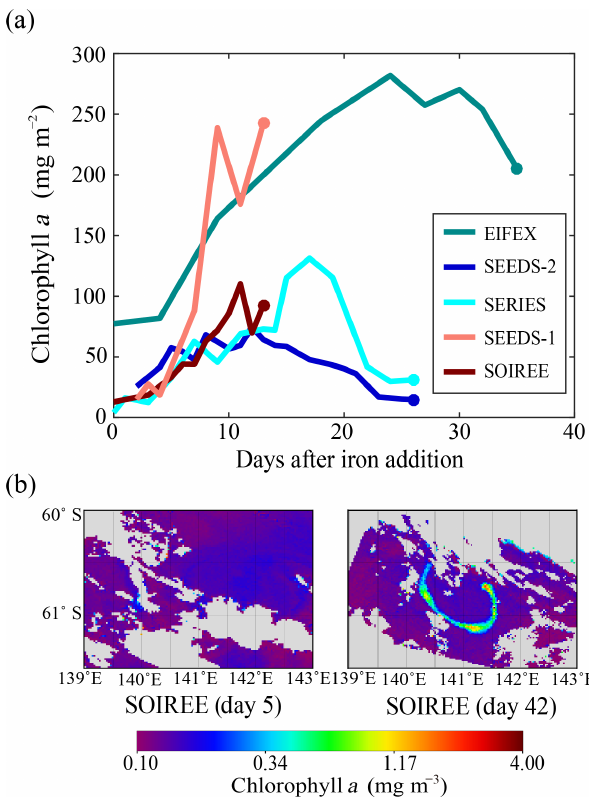
Figure 10. (a) Time series of mixed-layer-depth-integrated chloro- phyll a concentrations (mgm − 2 ) during the Southern Ocean Iron Release Experiment (SOIREE) (brown line), Subarctic Pacific iron Experiment for Ecosystem Dynamics Study 1 (SEEDS-1) (coral line), Subarctic Ecosystem Response to Iron Enrichment Study (SE- RIES) (cyan line), SEEDS-2 (blue line), and European Iron Fer- tilization Experiment (EIFEX) (teal line). (b) The distributions of chlorophyll a concentrations (mgm − 3 ) on day 5 and day 42 during SOIREE from SeaWiFS Level-2 daily images. Sources are Gall et al. (2001a), Tsuda et al. (2007), and Assmy et al.